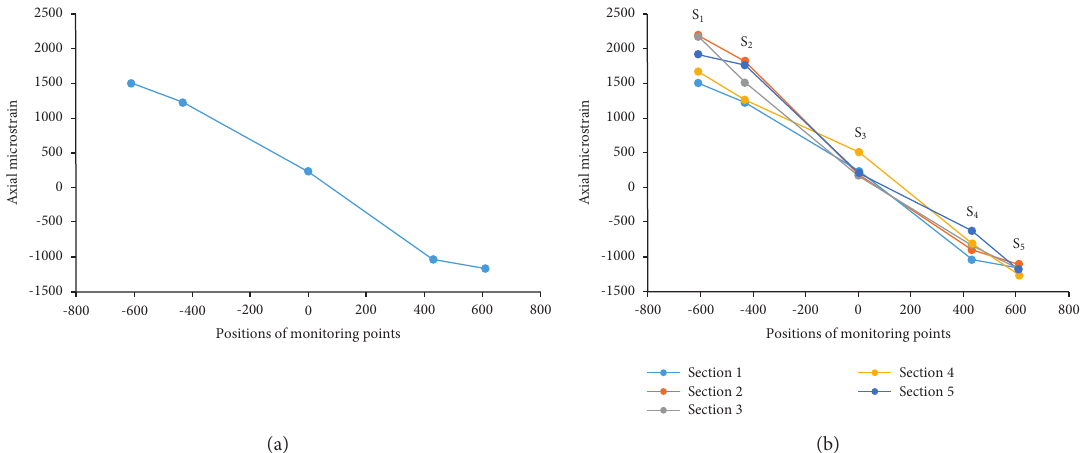
Figure 13: Monitoring results of VWGs: (a) pipe section 1; (b) pipe sections 1 ∼ 5.